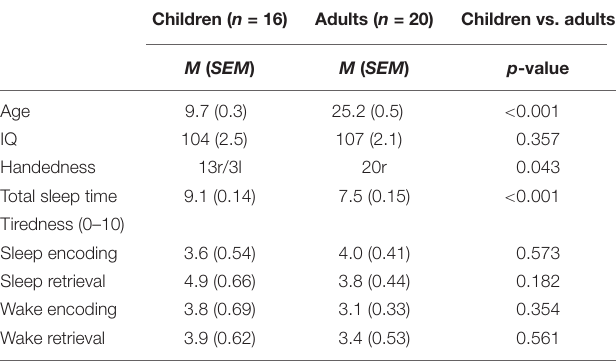
TABLE 1 | Participants’ characteristics and control variables.